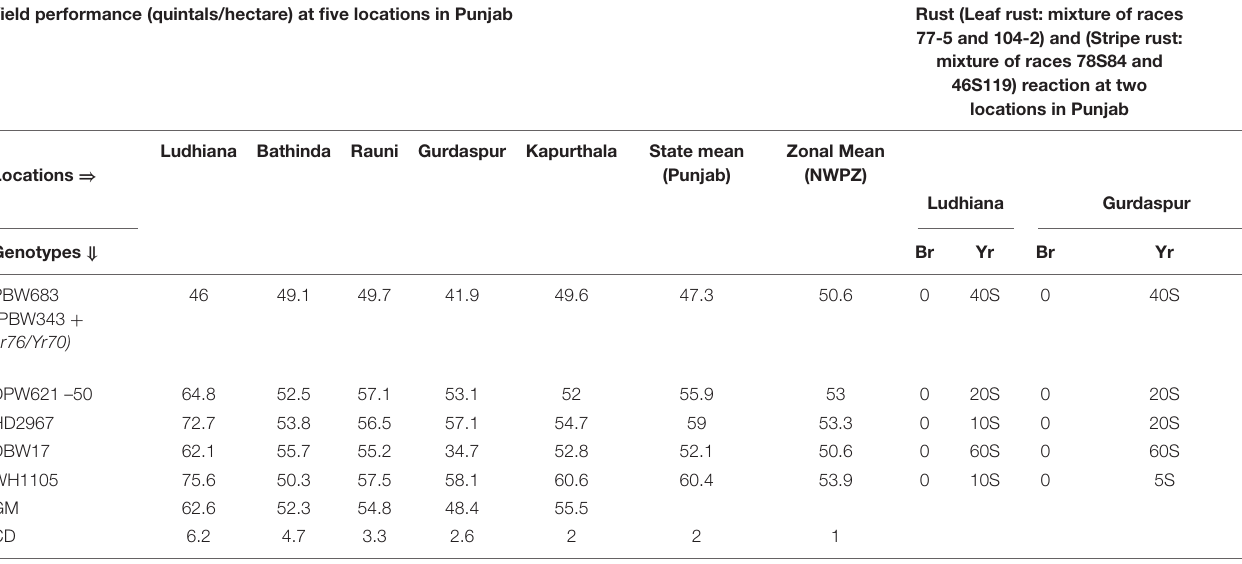
TABLE 3 | Yield performance and rust score of PBW683 in AVT at different locations across Punjab during 2012–2013. Yield performance (quintals/hectare) at five locations in Punjab Rust (Leaf rust: mixture of races